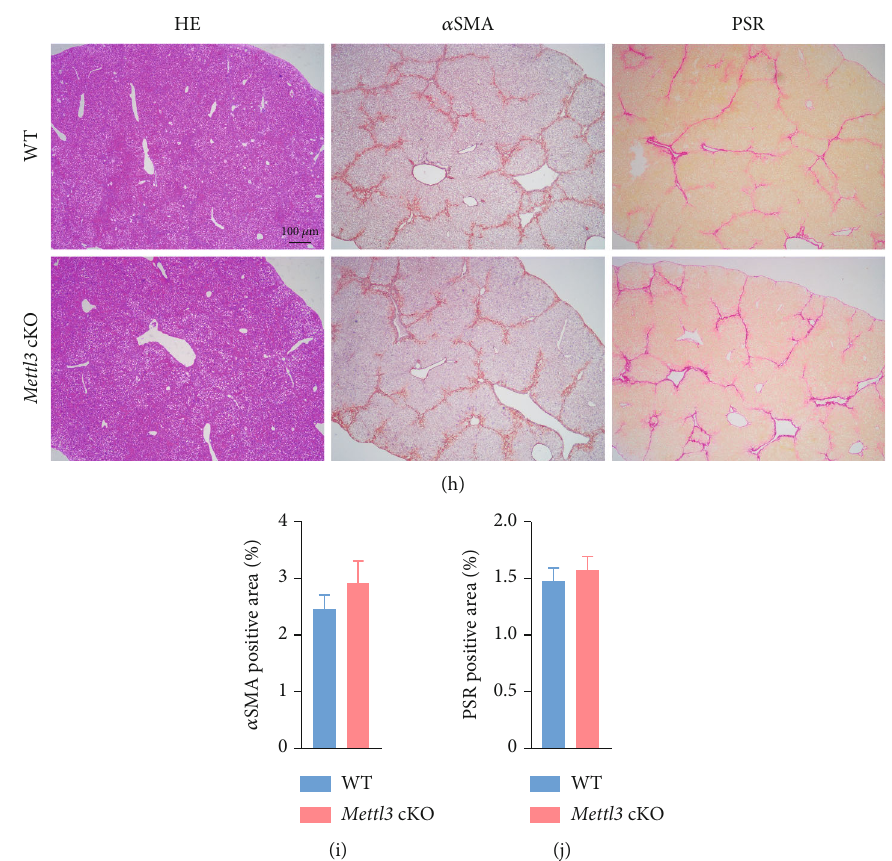
Figure 6: Knockout of Mettl3 does not a ff ect the pro- fi brogenic activity of B cells in liver fi brosis. (a) Quantitation of mRNA expression level of Mettl3 in B cells isolated from mouse livers treated with CCl or Oil (control) for 6 weeks. Results were retrieved from published 4 microarray data [47]. (b) Schematic diagram of CCl -induced mouse liver fi brosis. (c, d) Quanti fi cation of fl ow cytometry analysis for B 4 cell activation marker CD86 and CD95 in the spleen (c) and liver tissues (d) of WT control and Mettl3 cKO mice after fi brosis induction. (e) Serum levels of alanine aminotransferase (ALT), aspartate aminotransferase (AST), albumin (ALB), and alkaline phosphatase (ALP) levels in indicated groups 24 h after the last CCl treatment ( n = 5 for WT control and n = 6 mice for Mettl3 cKO). (f 4 ) RT-qPCR for pro fi brogenic genes of liver tissues in indicated groups ( n = 5 for WT control and n = 6 for Mettl3 cKO). (g) Representative western blot (left) and quanti fi cation (right) for pro fi brogenic genes in indicated groups ( n = 5 /group). Gapdh was used as a loading control. (h) Representative photographs of H&E staining (left), α SMA immunohistochemistry staining (middle), and picrosirius red (PSR) staining (right) of fi brotic liver sections from WT control and Mettl3 cKO mice. (i, j) Quanti fi cation of the aSMA positive area (i) and PSR staining positive area (j) in indicated groups ( n = 5 for WT control and n = 6 for Mettl3 cKO). Data in (a), (c) – (f), and (i, j) were presented as means ± SEM with the indicated signi fi cance ( ∗ P < 0 : 05 ; student ’ s t